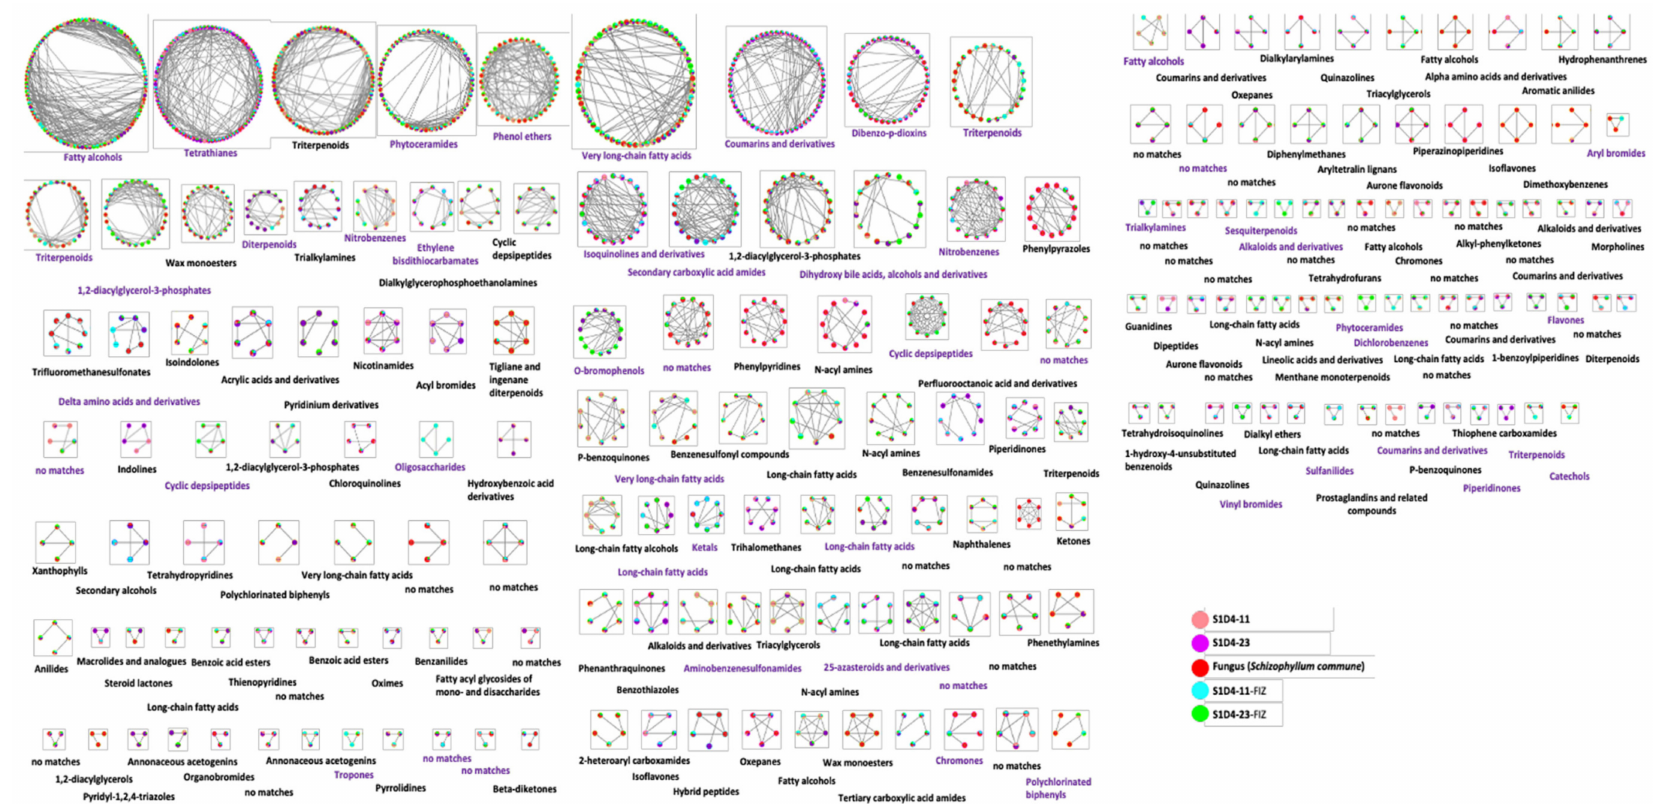
Figure 5. Molecular networking of ions produced during mono- and co-cultures. Data were obtained byLC-MS/MS in both positive and negative modes and were analyzed through GNPS. Each spectrum is shown as a node and related metabolites are linked by edges. Node color represents fractions by a chromatographic separation (C18 reverse phase) prior MS/MS detection. For both SFIZ extracts, the activity against the indicator strain was only found in two fractions (N ◦ 22 and 23). To identify potential candidates induced during the studied interactions, we selected compounds found in fractions 22 and 23 and in SFIZs but not in the controls (Figure 6). As control extracts were solubilized in dimethyl sulfoxid (DMSO) (see previous paragraph), we restricted this analysis to SFIZ extract molecules found in both DMSO and methanol, recognizing that some methanol-soluble and DMSO-insoluble candidates could be